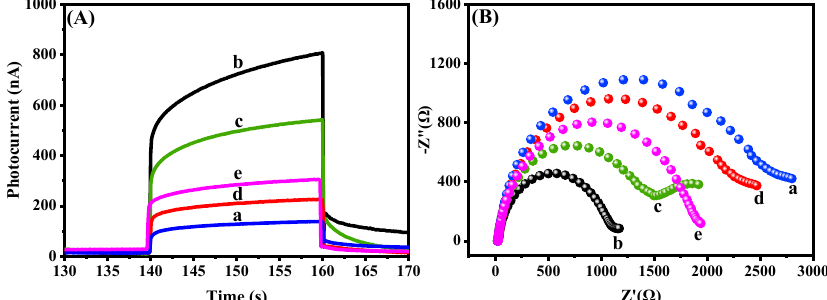
Figure 2. ( A ) Photocurrent responses and ( B ) electrochemical impedance spectra of (a) g-C 3 N 4 /FTO; (b) g-C 3 N 4 /BiVO 4 /FTO; (c) g-C 3 N 4 /BiVO 4 /Aptamer/FTO; (d) g-C 3 N 4 /BiVO 4 /Aptamer/BSA/FTO; (e) g-C 3 N 4 /BiVO 4 /Aptamer/BSA/TC/FTO.